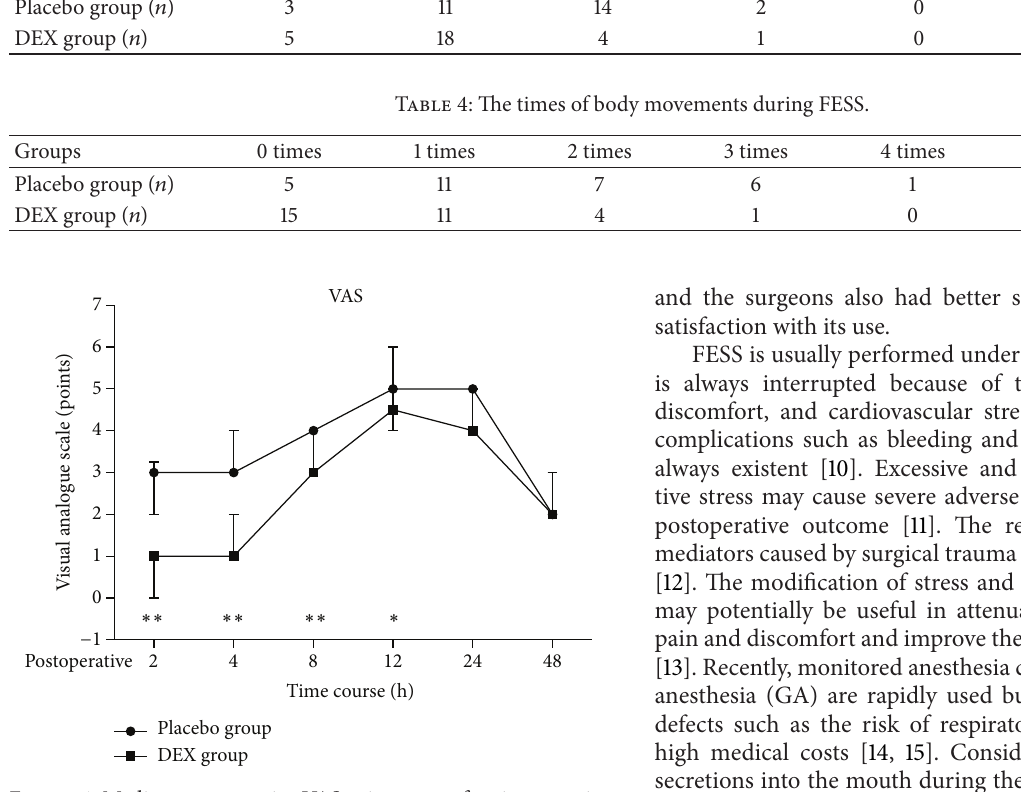
Figure 4: Median postoperative VAS pain scores of patients receiv- ing intranasal DEX and placebo at each recording time point. The areas under curves (AUC) of VAS pain scores for 2–12 h were significantly lower in DEX group than Placebo group ( 𝑃 < 0 .